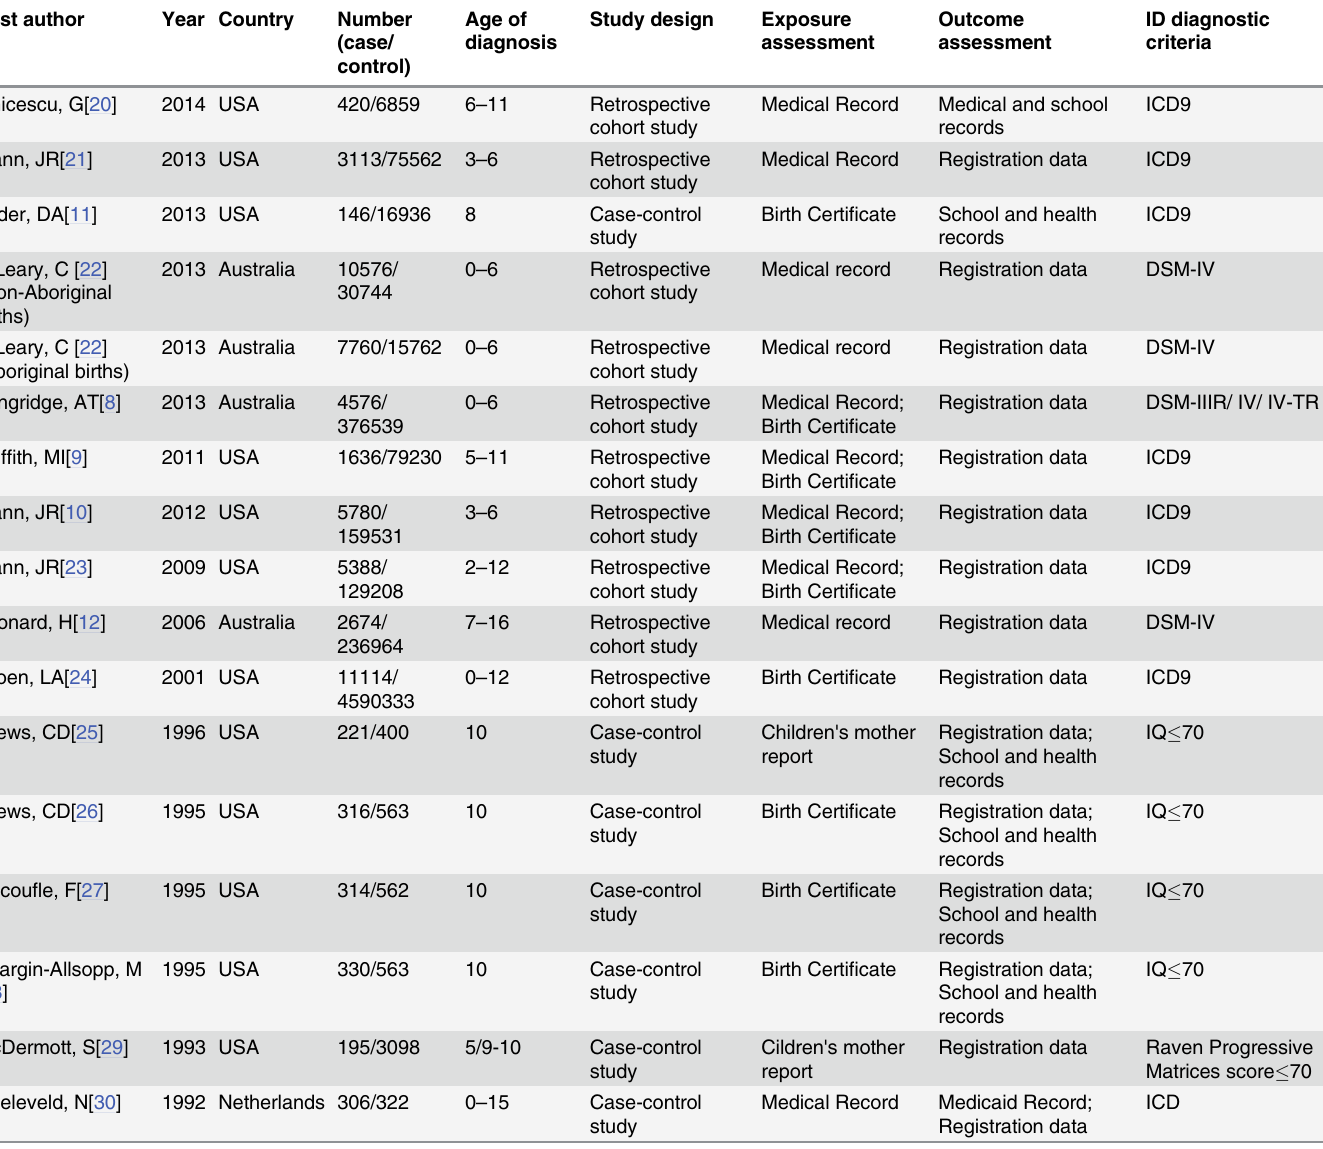
Table 1. Characteristics of the included studies in